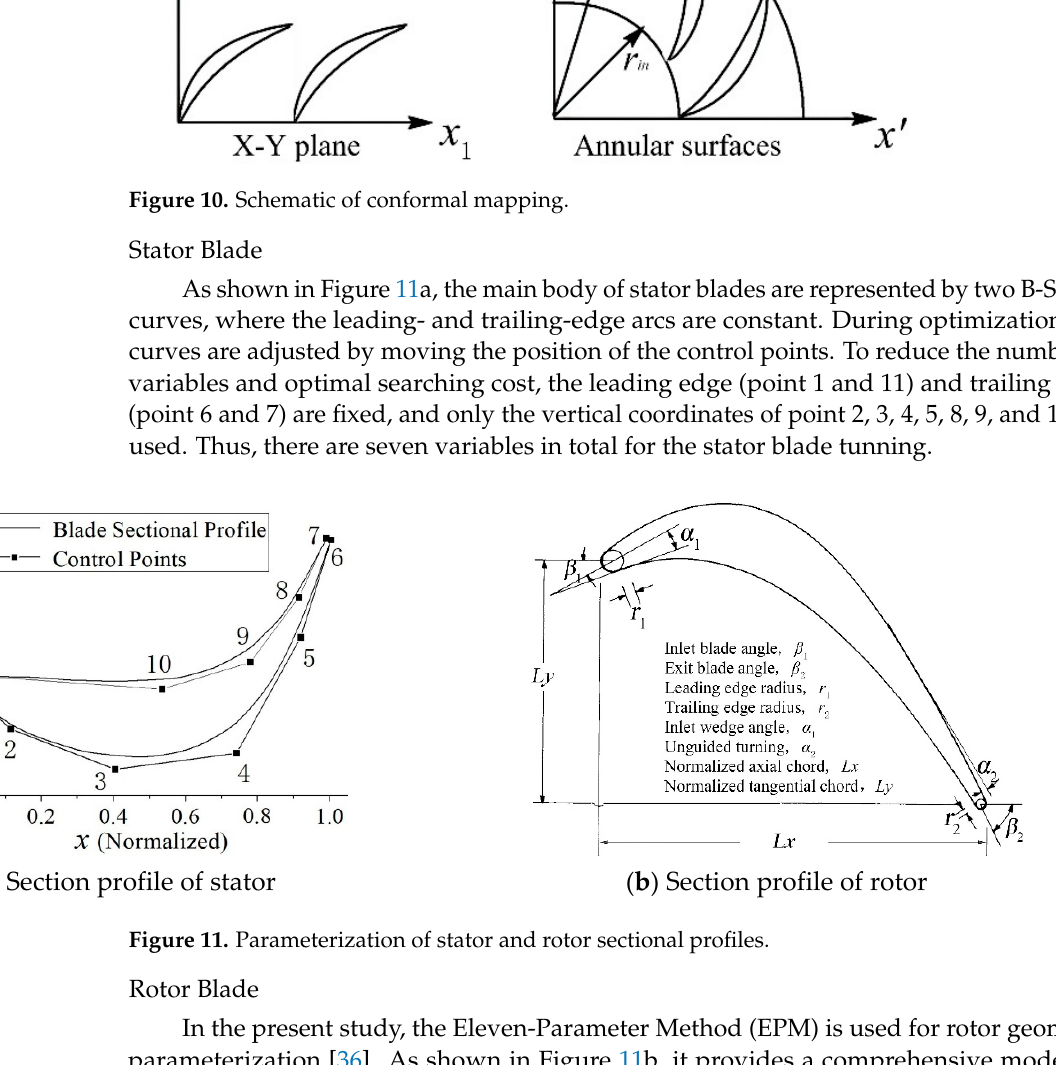
Figure 11. Parameterization of stator and rotor sectional profiles.